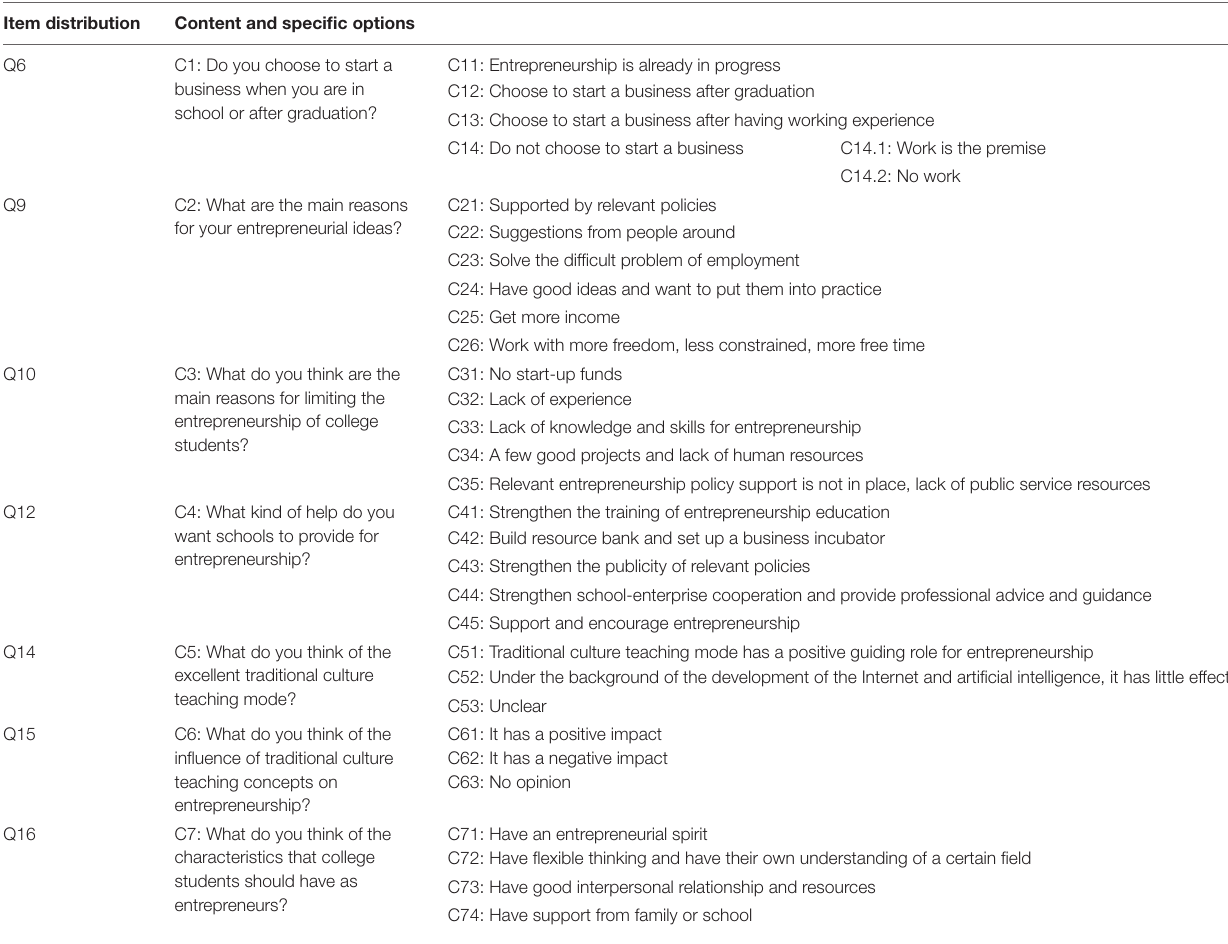
TABLE 1 | Key question setting of the questionnaire. Item distribution Content and specific